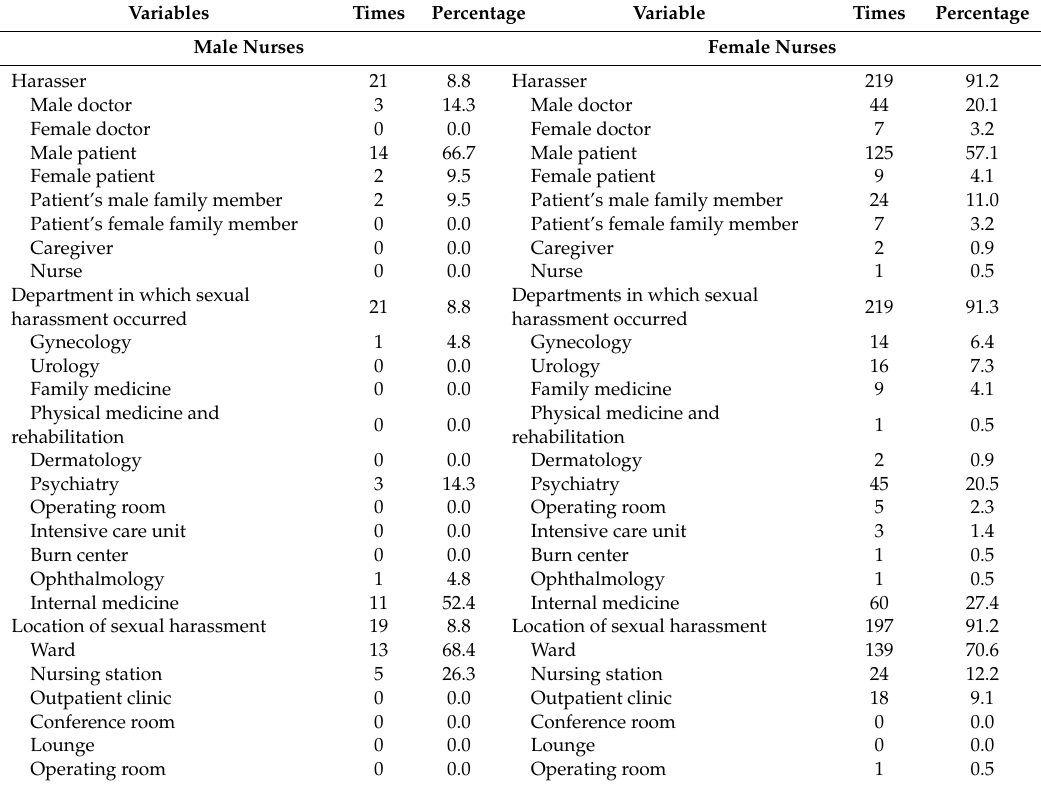
Table 2. Experience of sexual harassment during clinical practicum ( n =